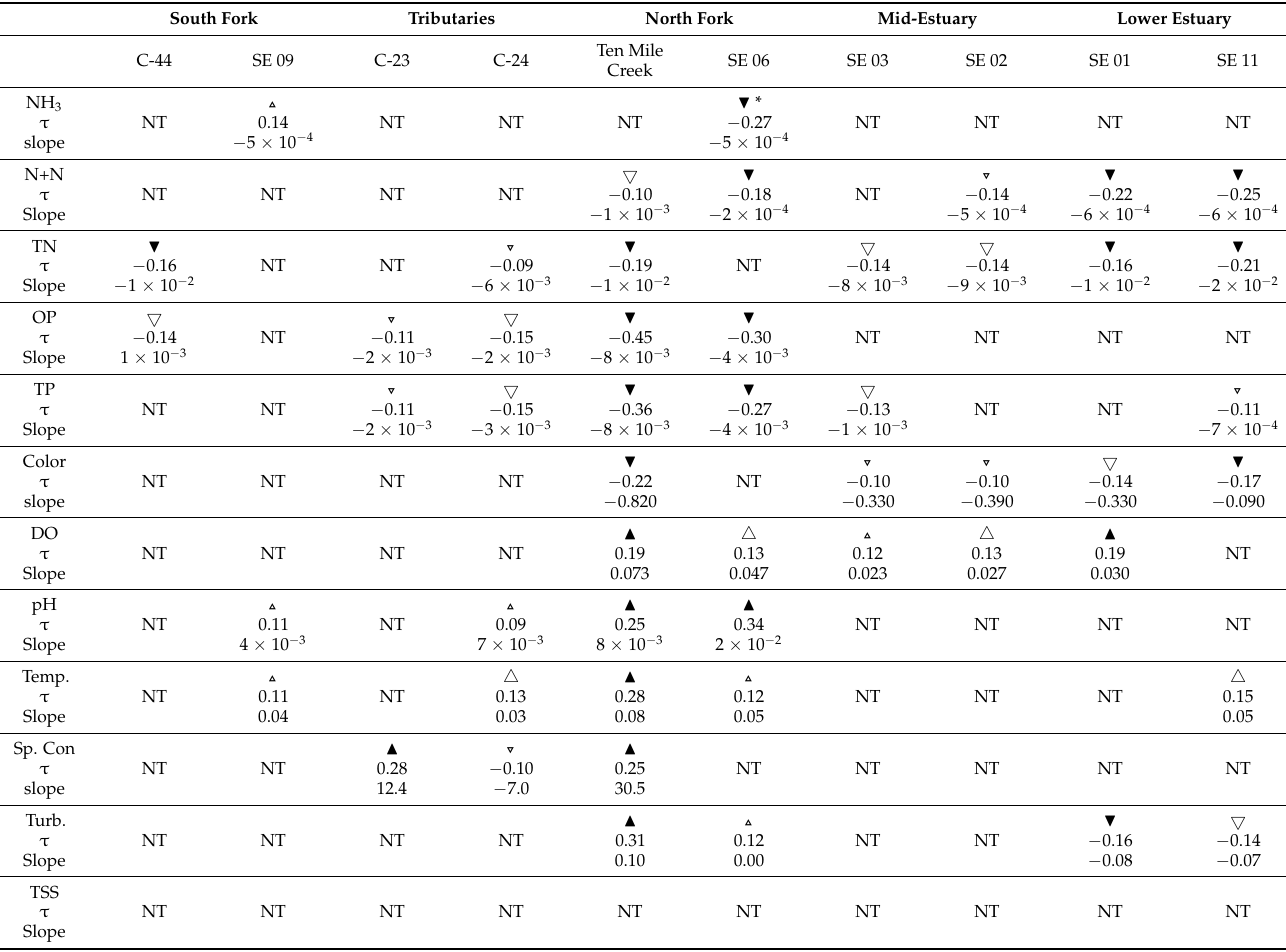
Table 5. The Seasonal Mann –Kendall test and the Sen’s slope were performed for the twenty years for each variable in each station to test for the significance, direction, and magnitude of non-seasonal trends.